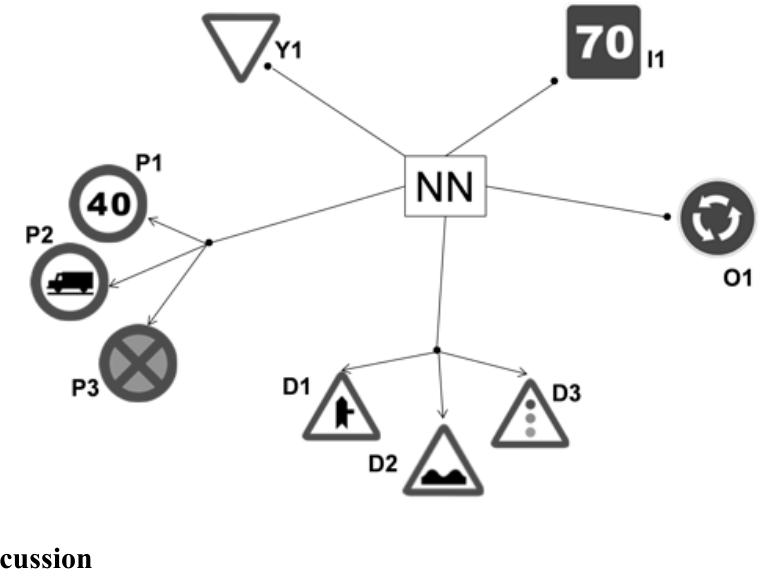
Figure 12. Examples of the output of the cascade network for road sign recognition. Each figure shows the group it belongs